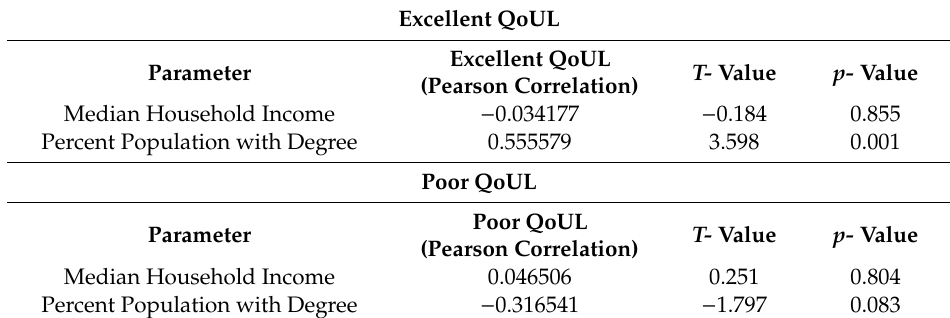
Table 11. Results of the partial correlation analysis predicting excellent and poor QoUL from the hypothesized dominant education / income